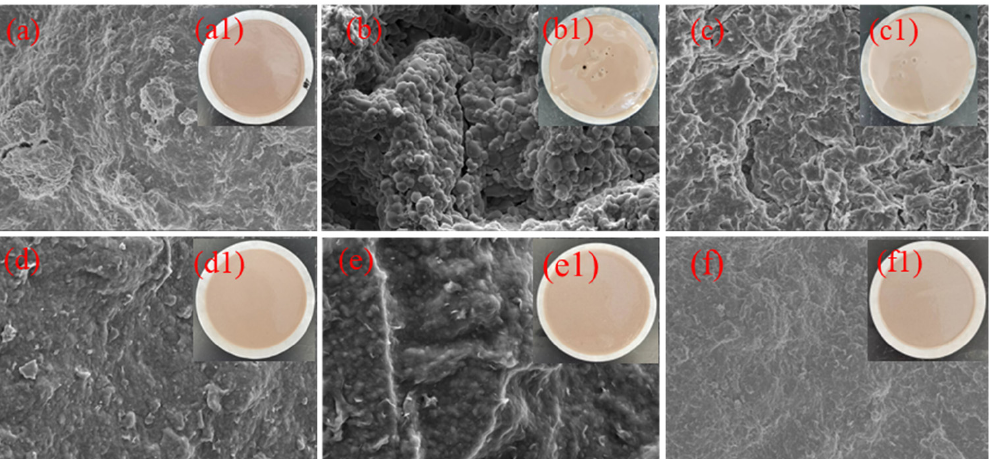
Figure 7. ( a − f ) SEM of filter cakes; ( a1 − f1 ) digital images of filter cakes; ( a , a1 ) WBDF; ( b , b1 ) 20Na -WBDF; ( c , c1 ) 5Ca-WBDF; ( d , d1 ) DNDAP/WBDF; ( e , e1 ) DNDAP/20Na -WBDF; ( f , f1 ) DNDAP/5Ca-WBDF.